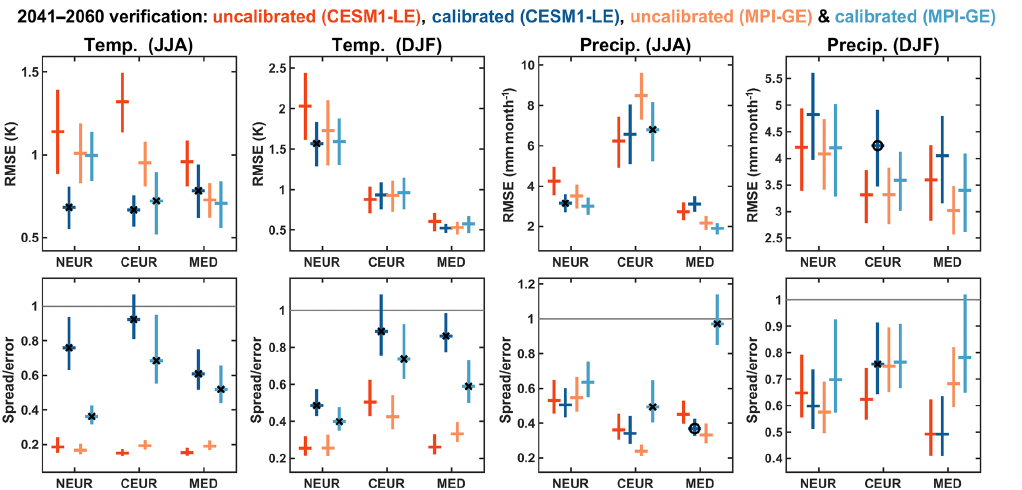
Figure 6. Verification of the 2041–2060 mean projections calculated relative to the out-of-sample CMIP5 models for both the CESM1-LE and MPI-GE datasets. The horizontal lines show the mean across all models and the vertical lines show the 90% confidence intervals, cal- culated by randomly resampling across the CMIP5 models with replacement 1000 times. The black crosses indicate where the calibrated ensemble is significantly better than the equivalent uncalibrated ensemble; the black circles indicate where the calibrated ensemble is signif- icantly worse that the uncalibrated